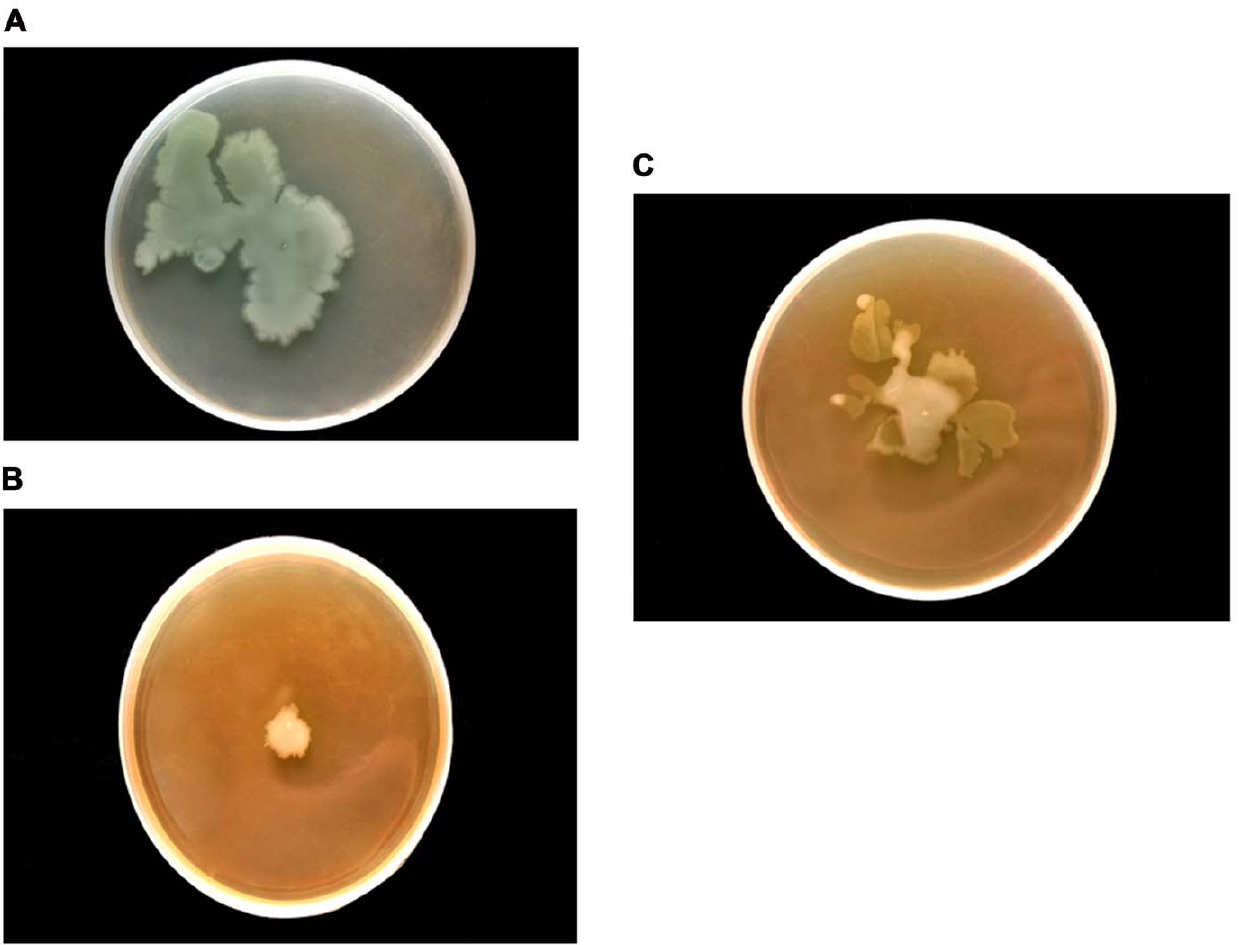
Figure 7. Swarming motility of P.aeruginosa PAO1 a) Untreated b) Treated with 0.5 mg/ml of F7 c) reversal of inhibited swarming motility by the addition of exogenous C 4 HSL(2 m